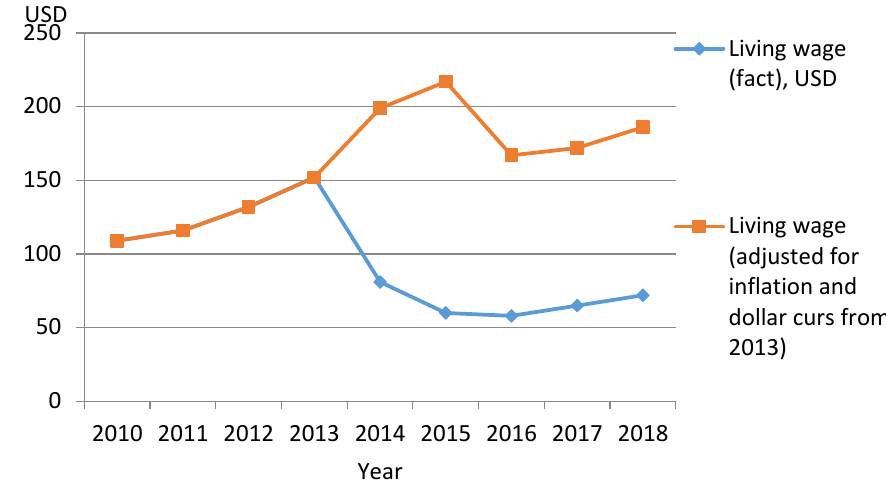
Fig. 8: Minimum subsistence level (Living Wage) (factual and adjusted) in Ukraine (Minfin, 2019)